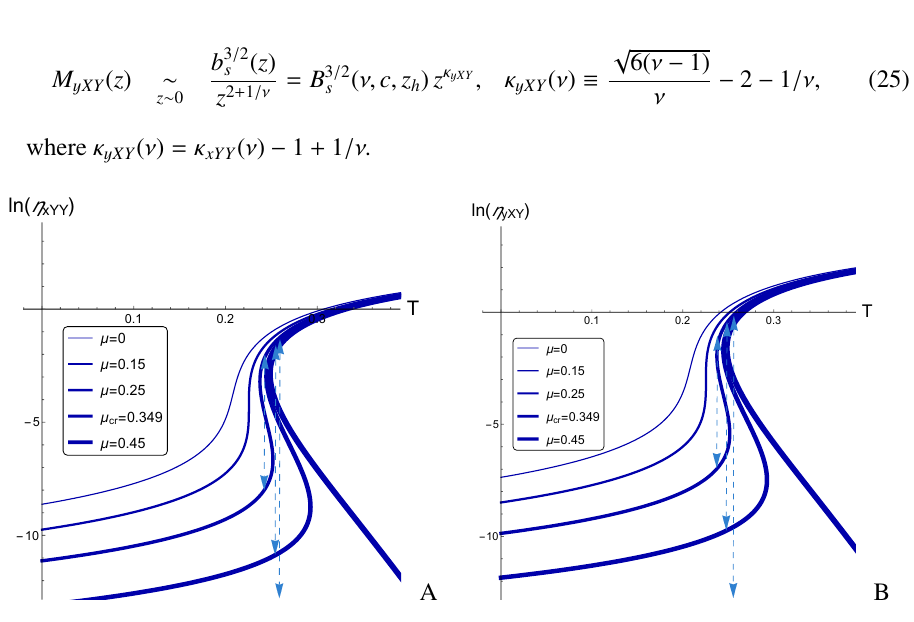
Figure 5. HEE density for A) xYY and B) yXY orientations, c = potentials, (cid:31) =